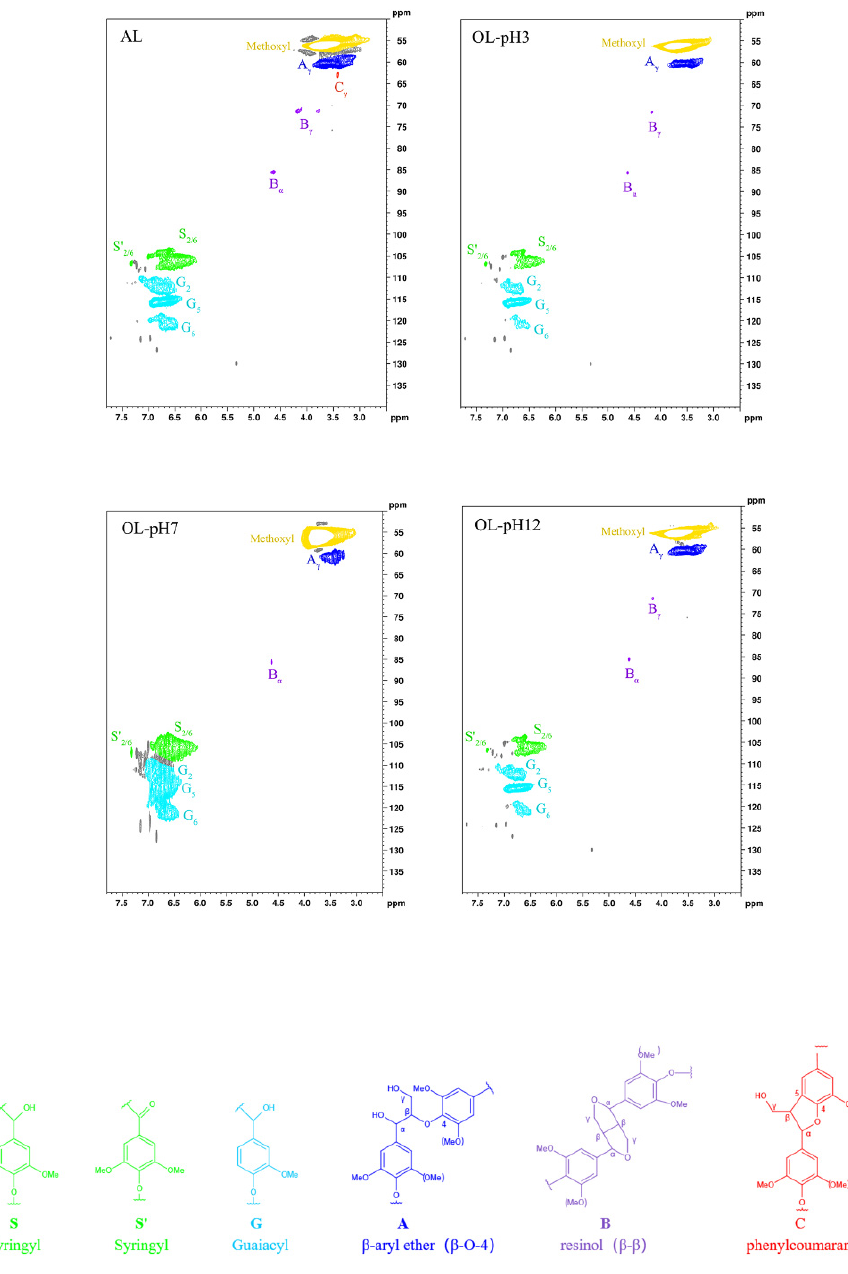
Figure 3. 1 H- 13 C HSQC NMR spectra from the untreated and ozone pretreated alkali lignin. Table 4. Weight average (M w ) and number average (M n ) molecular weights, and polydispersity indexes (M w /M n ), of the four lignin Table 3. Semi-quantitative information for lignin subunits and inter-unit linkages in the untreated and ozone pretreated alkali lignin.